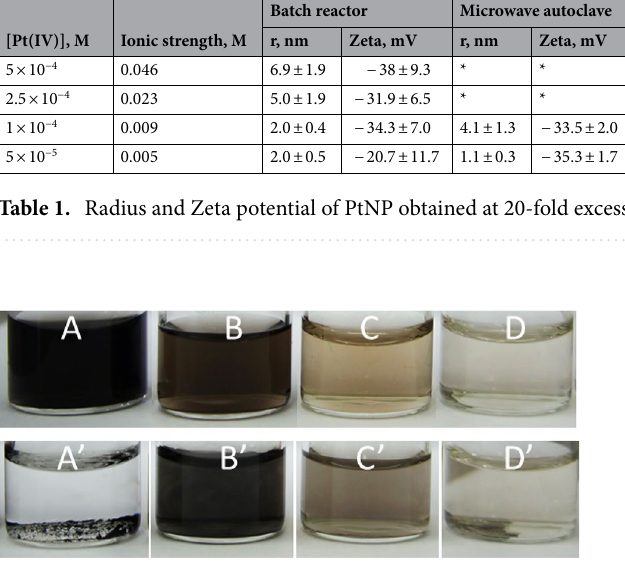
Figure 6. Photographical depiction of the reaction mixtures obtained after reduction in the batch ( A – D ), t = 120 min, T ≈ 100 °C and microwave autoclave reactor ( A ′ – D ′ ), t = 10 min, T max ≈ 225 °C; chemical composition of the reaction mixture: ( A , A ′ ) [Pt(IV)] = 5 × 10 −4 M, ( B , B ′ ) [Pt(IV)] = 2.5 × 10 −4 M, ( C , C ′